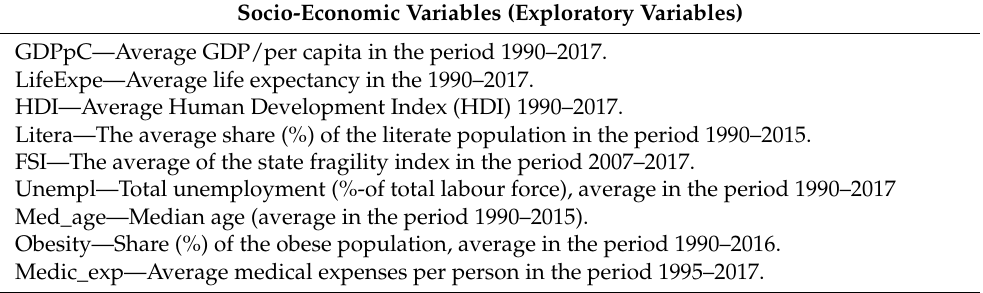
Table 2. Socio-economic variables (Source: World